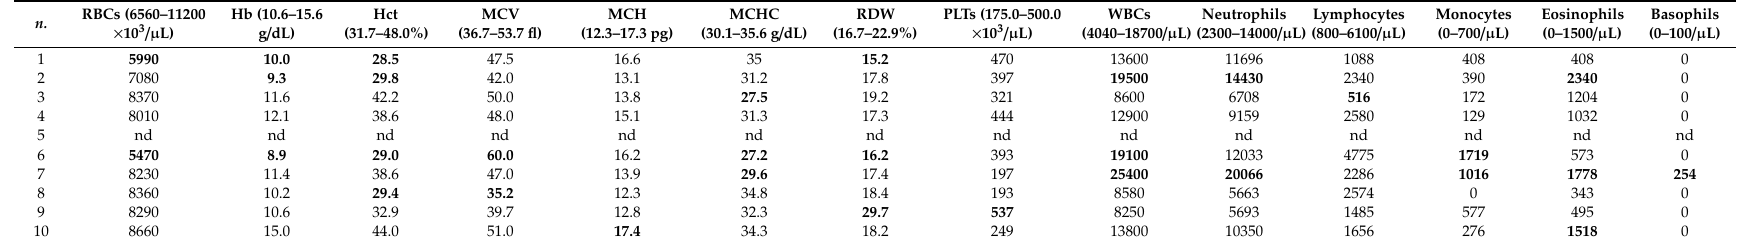
Table 5. Complete blood count values in L. infantum infected stray cats from Northern